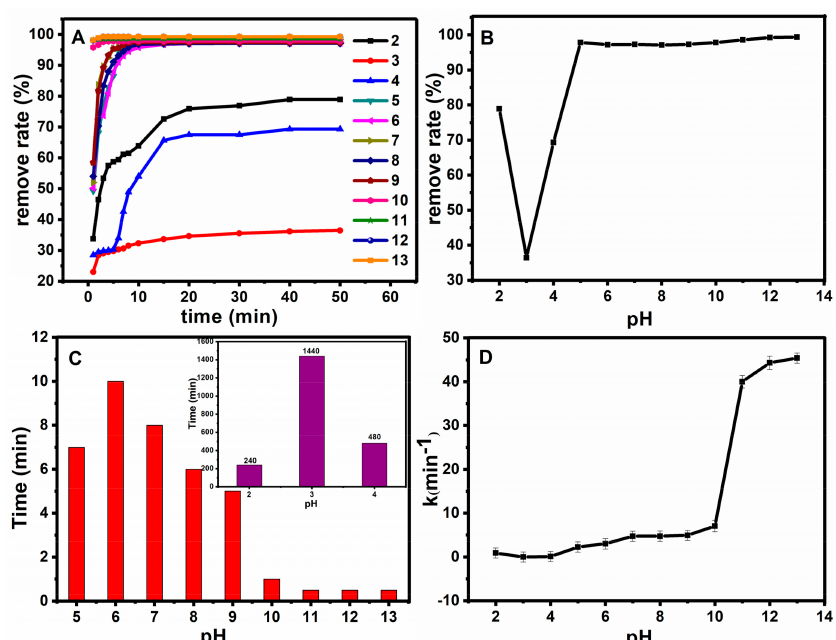
Figure 11. Effect of pH on oxidation rate ( A ); The relationship between pH and the removal degree after half an hour ( B ); The relationship between pH and time when the removal degree reached 98% ( C ); the relationship between pH and the work rate ( D